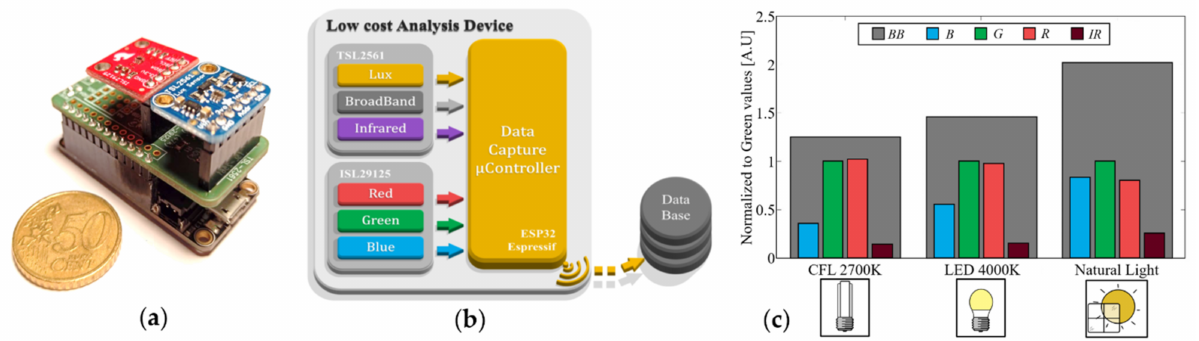
Figure 2. ( a ) the compact sensor (analysis system tool) that gives light information via photodiodes dedicated to the broadband spectra, the infrared, the red, the green and the blue; ( b ) information collected and sent via an ESP32; ( c ) typical pseudospectra obtained under different light sources like CFL, LED or natural light through a window